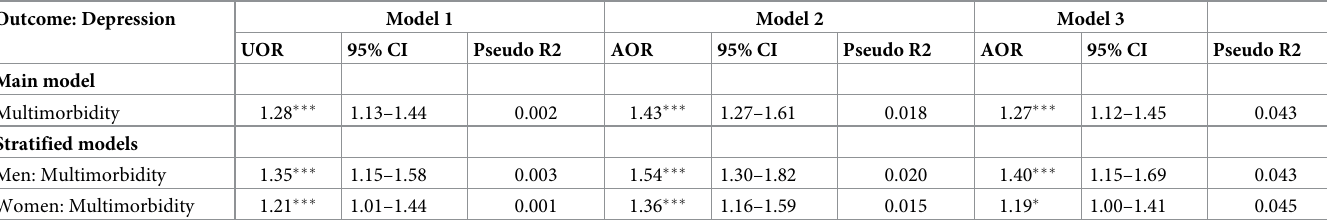
Table 2. Associations between multimorbidity and depression among older adults: Logistic regression models. Outcome: